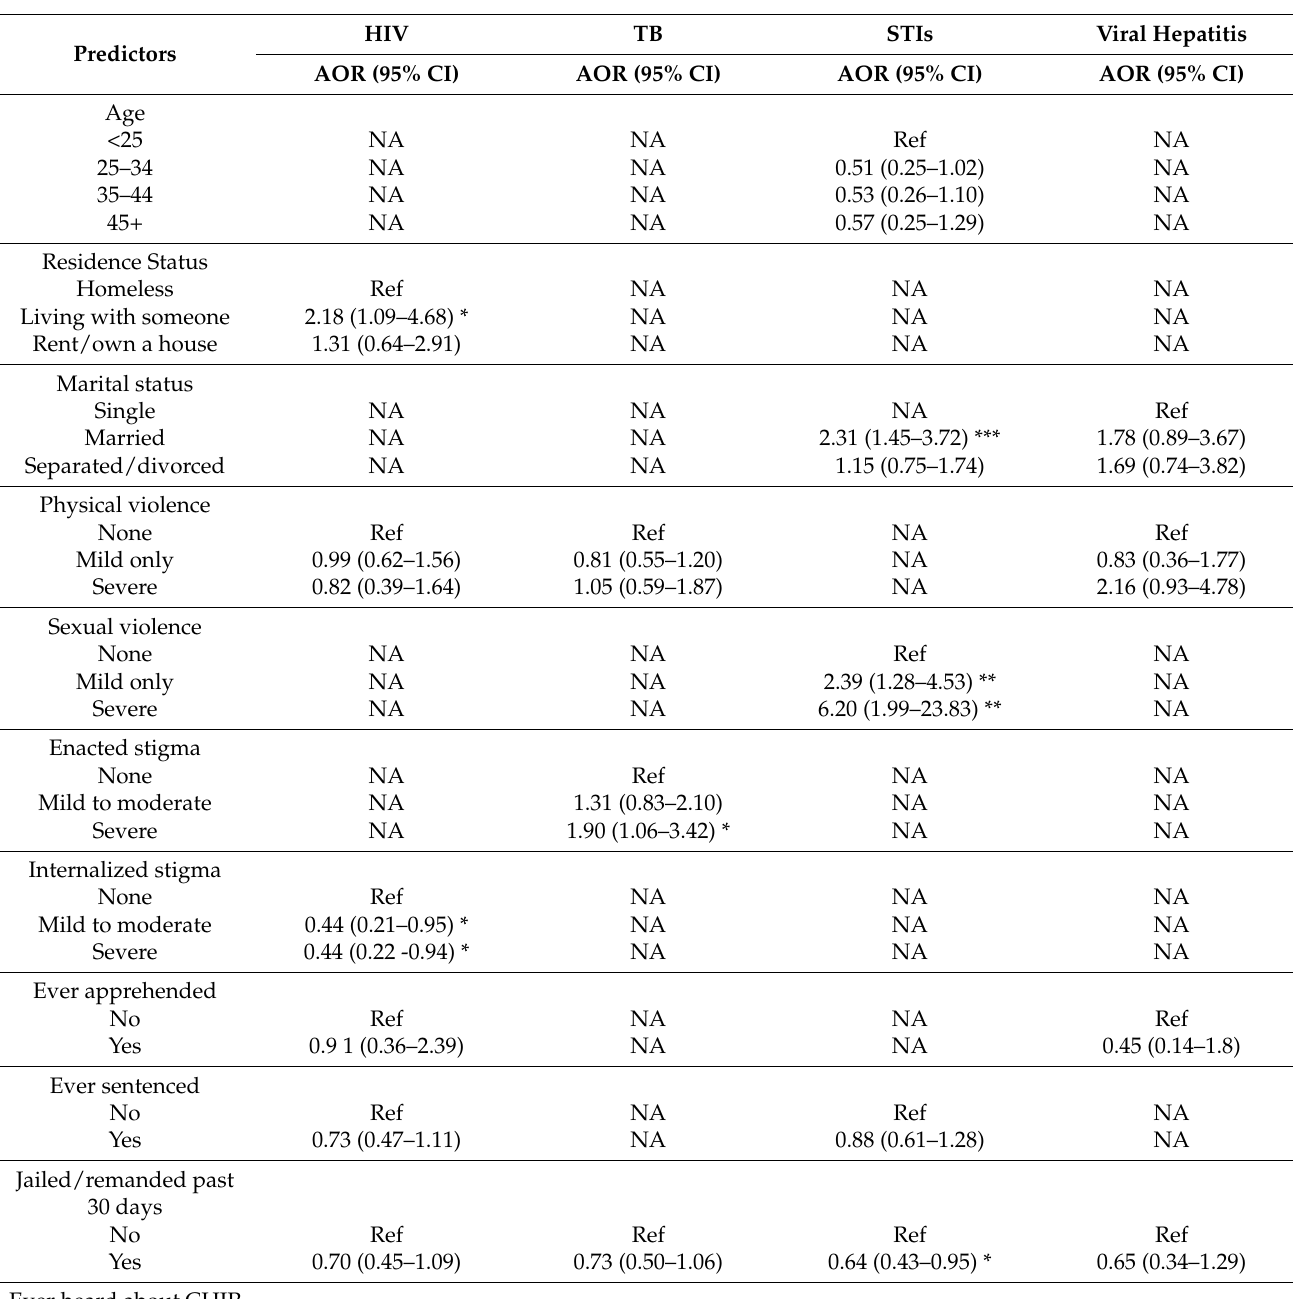
Table 4. Multivariate analyses for predictors of testing for drug-related infectious diseases